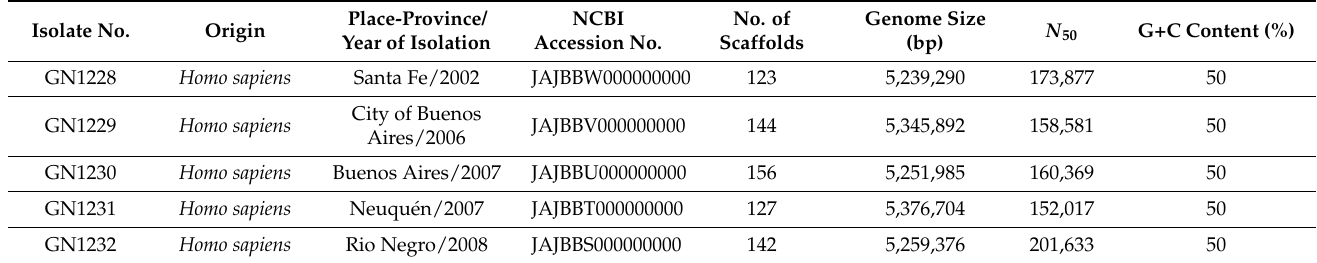
Table 2. Accession numbers and assembly metrics of the annotated STEC O145:NM[H28]. Isolate